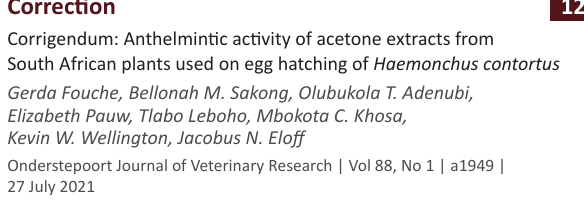
Correction Corrigendum: Anthelmintic activity of acetone extracts from South African plants used on egg hatching of Haemonchus contortus Gerda Fouche, Bellonah M. Sakong, Olubukola T. Adenubi, Elizabeth Pauw, Tlabo Leboho, Mbokota C. Khosa,